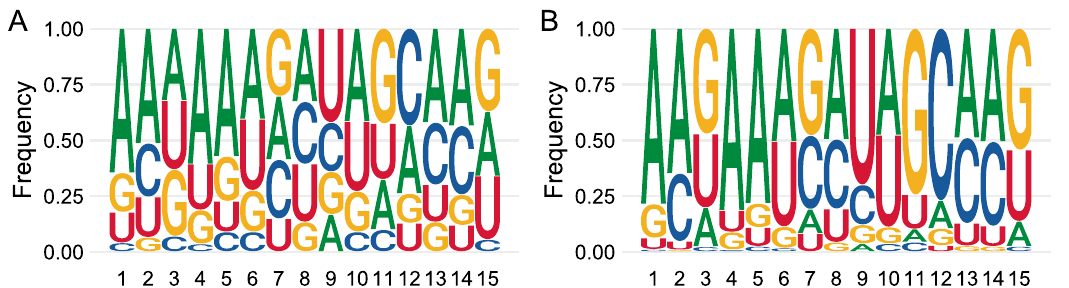
Figure 1. Sequence logo showing different bias signatures that were detected in mitochondrial piRNAs in our samples. ( A ) Counting all unique sequences. ( B ) Counting all